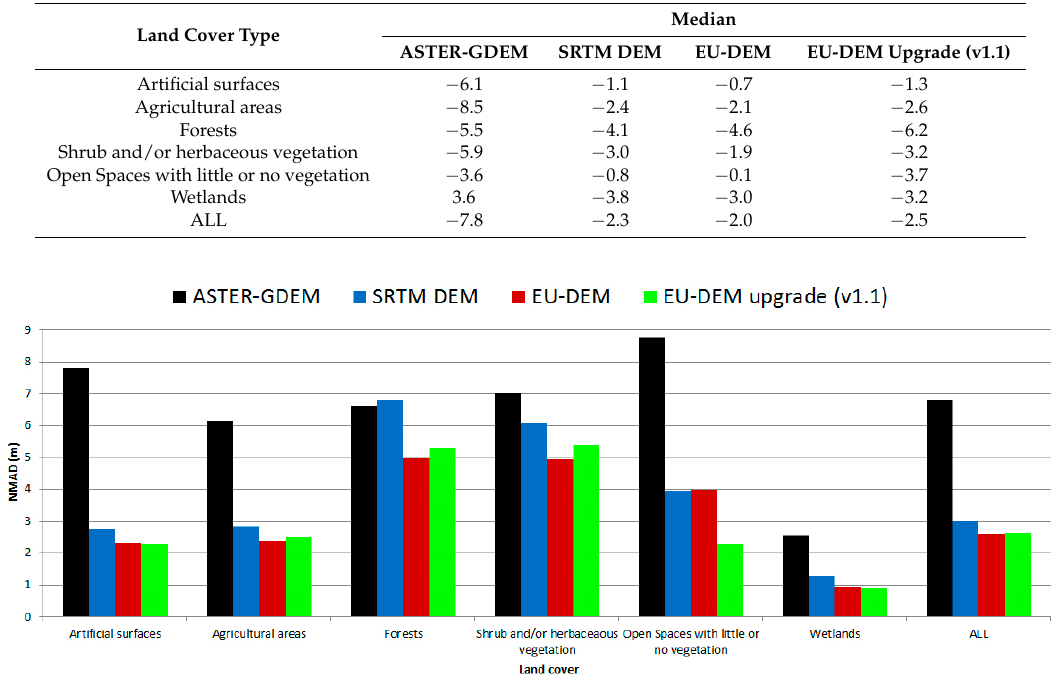
Figure 9. Median of absolute elevation errors plotted against different land cover classes. Table 3. Median of absolute elevation error values per land cover.